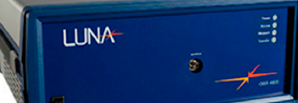
Figure 4. Burying the PCC pile.